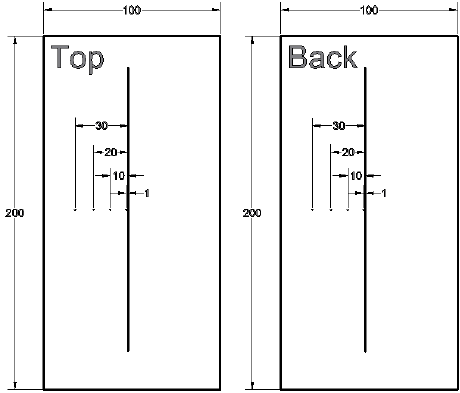
Figure 18. Schematic diagram of thermocouple attachment location.